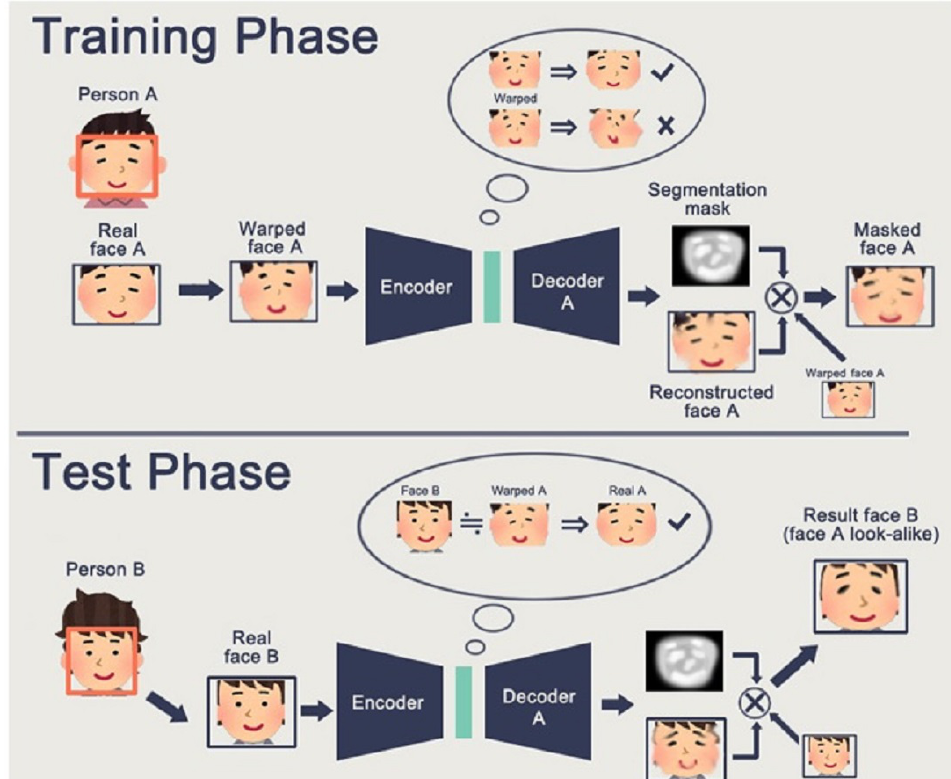
Figure 6. Training and testing phases of FC-GAN